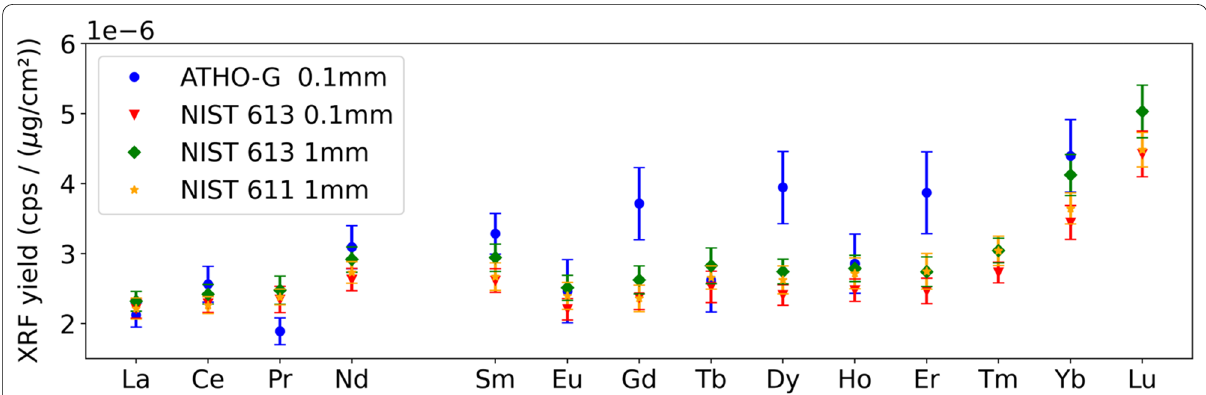
Fig. 4 XRF yields for the different reference materials that were investigated, as calculated by Eq. 2. Error bars indicate three standard error margins (99.7% confidence